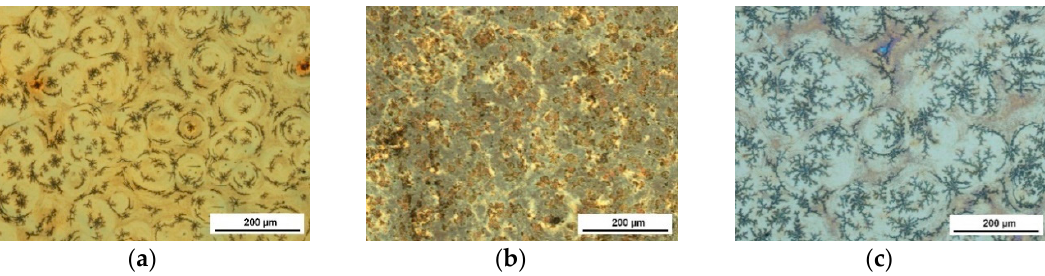
Figure 3. Microscopic images of composite coatings: TiO 2 + HAp ( a ), Al 2 O 3 + HAp ( b ), and ZrO 2 + HAp ( c ) deposited on Ti6Al7Nb alloy substrates.